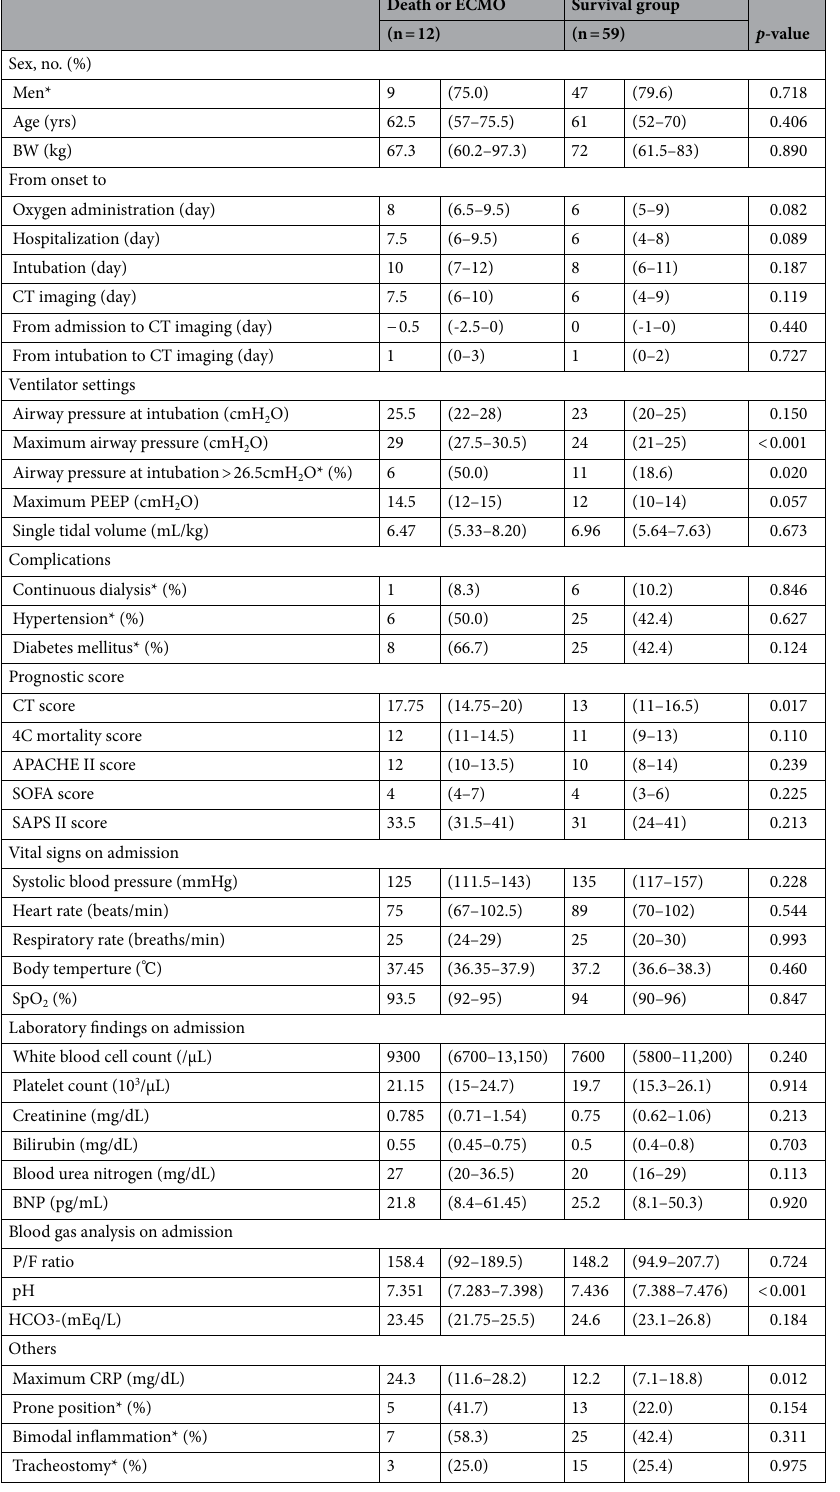
Table 1. Characteristics of patients at baseline. BW body weight, CT computed tomography, PEEP positive end expiratory pressure, CRP C-reactive protein, BNP brain natriuretic peptide, 4C coronavirus clinical characterisation consortium, APACHE acute physiology and chronic health evaluation, SOFA sequential organ failure assessment, SAPS simplified acute physiology score. *Frequency (%); Rest of data are expressed as medians